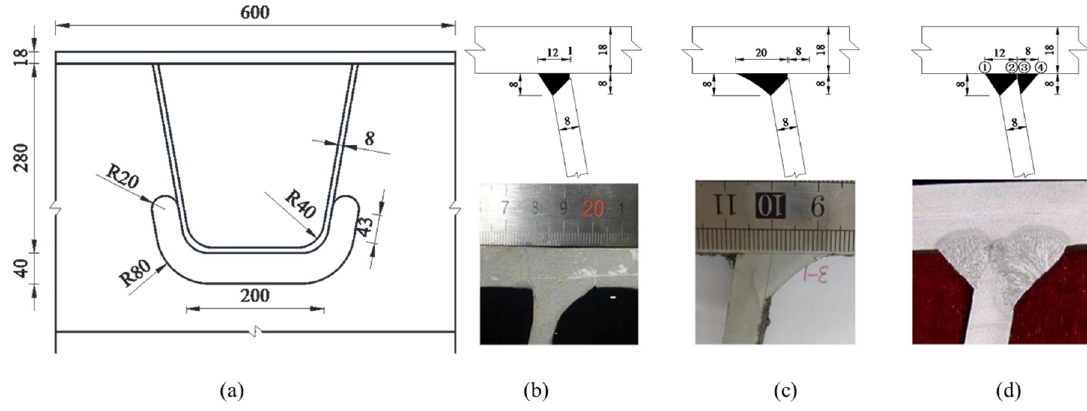
Figure 6. The detailed sizes (Unit: mm) of the orthotropic steel bridge deck (OSBD) and three typical connections. ( a ) Model of the OSBD; ( b ) traditional weld seam; ( c ) weld seam of large root; ( d ) double-